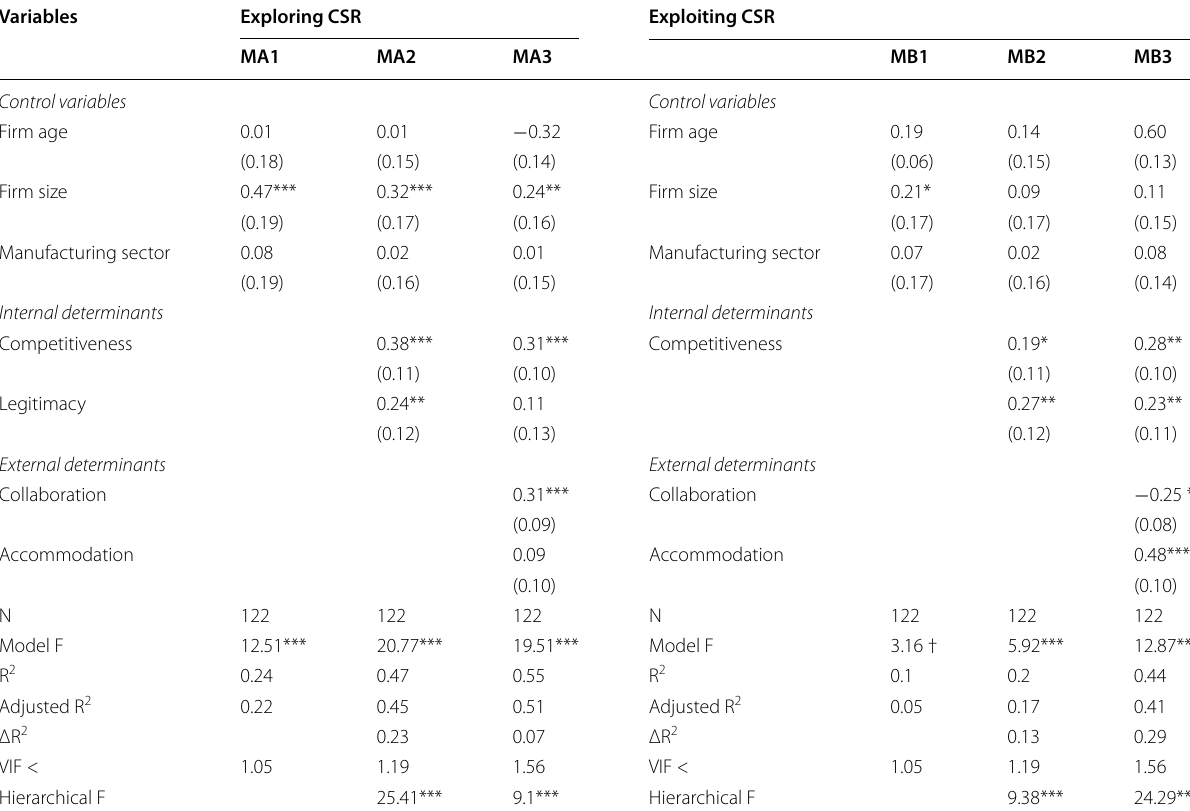
Table 2 Result of regression analyses: influence of firms’ internal and external determinants on different CSR practices